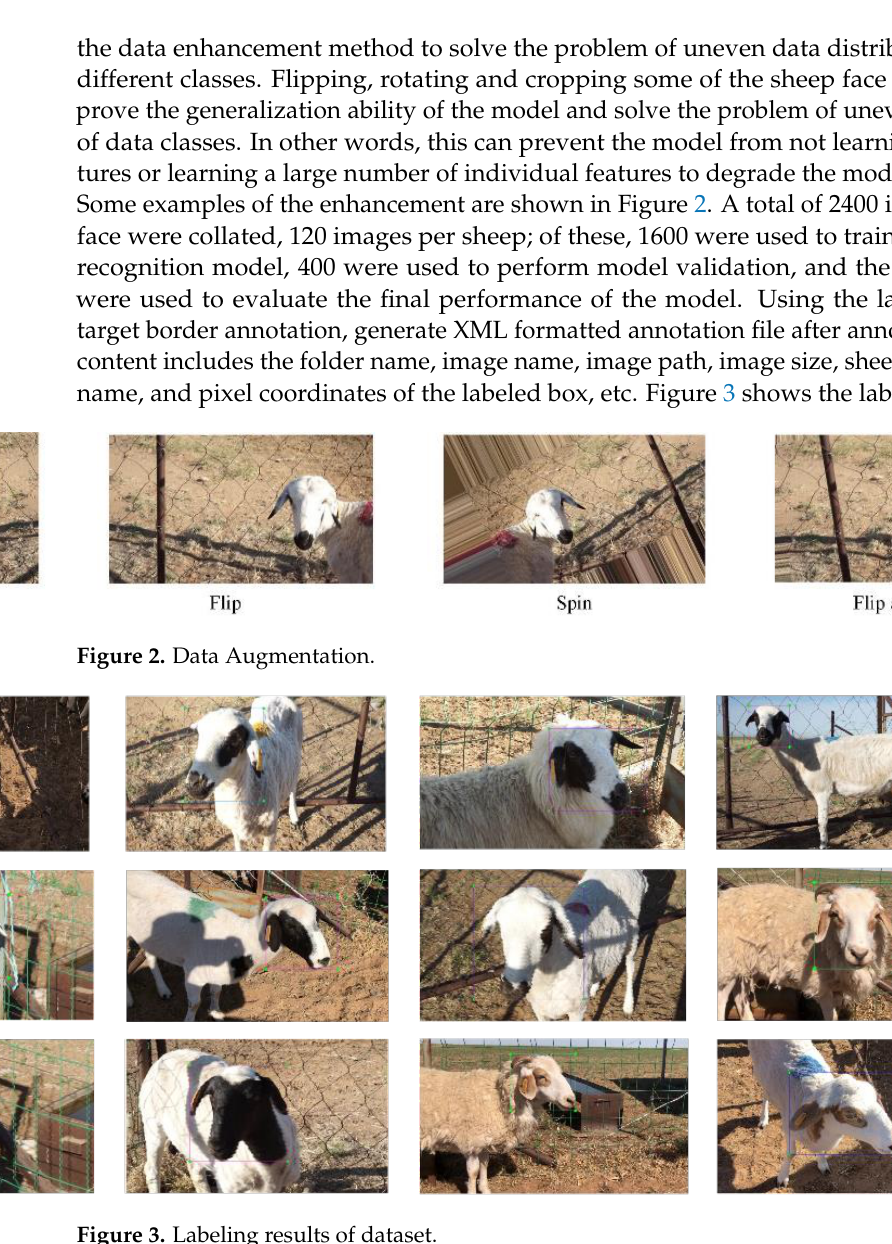
Figure 3. Labeling results of dataset.